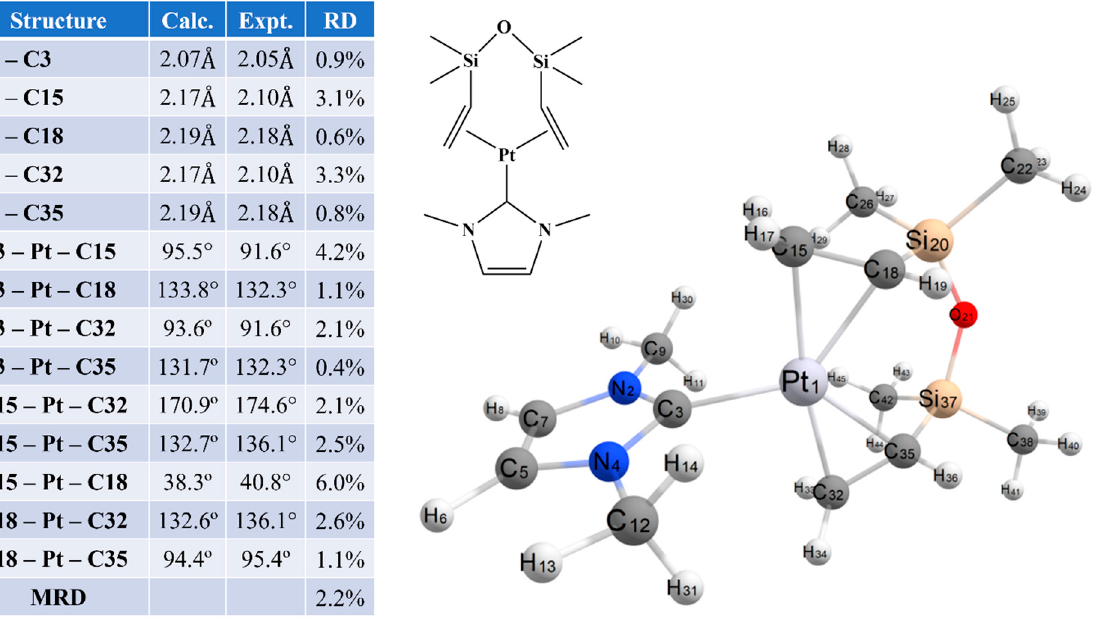
Figure 4. Pt(0)-carbene complex ([Pt(Icy)(dvtms)].